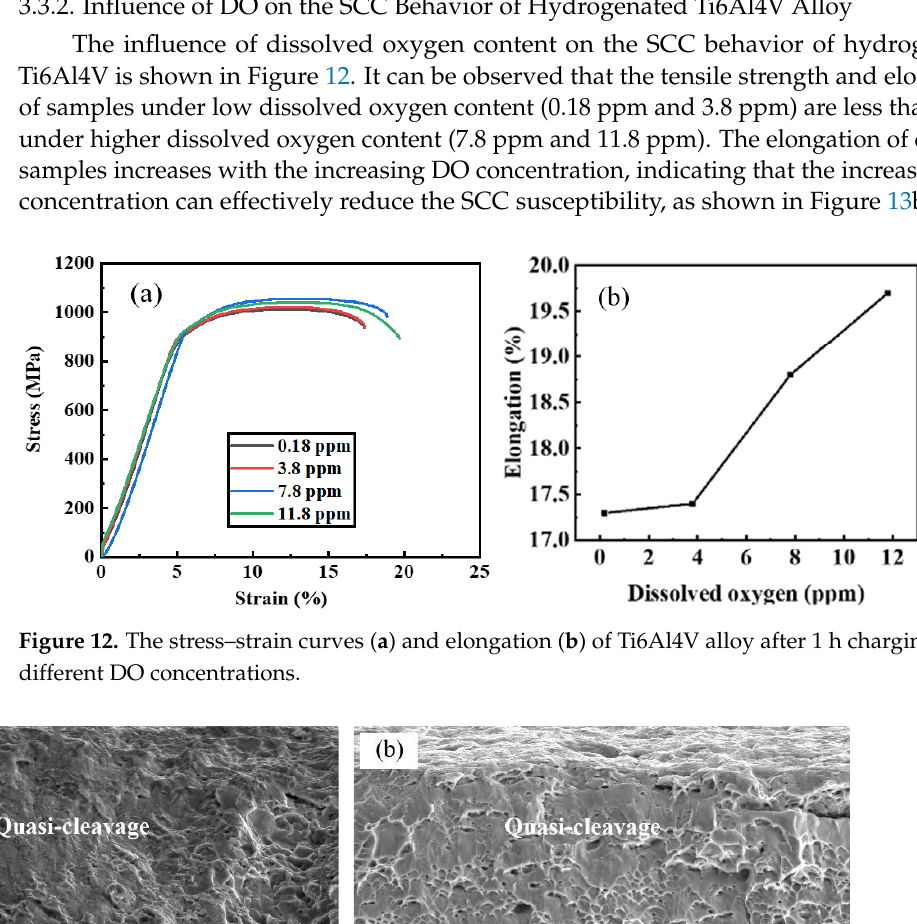
Figure 13. Fracture surface morphologies of 1 h charged Ti6Al4V alloy after SSRT under different DO concentrations: ( a ) 0.18 ppm; ( b ) 11.8 ppm. concentrations: ( a ) 0.18 ppm; ( b ) 11.8